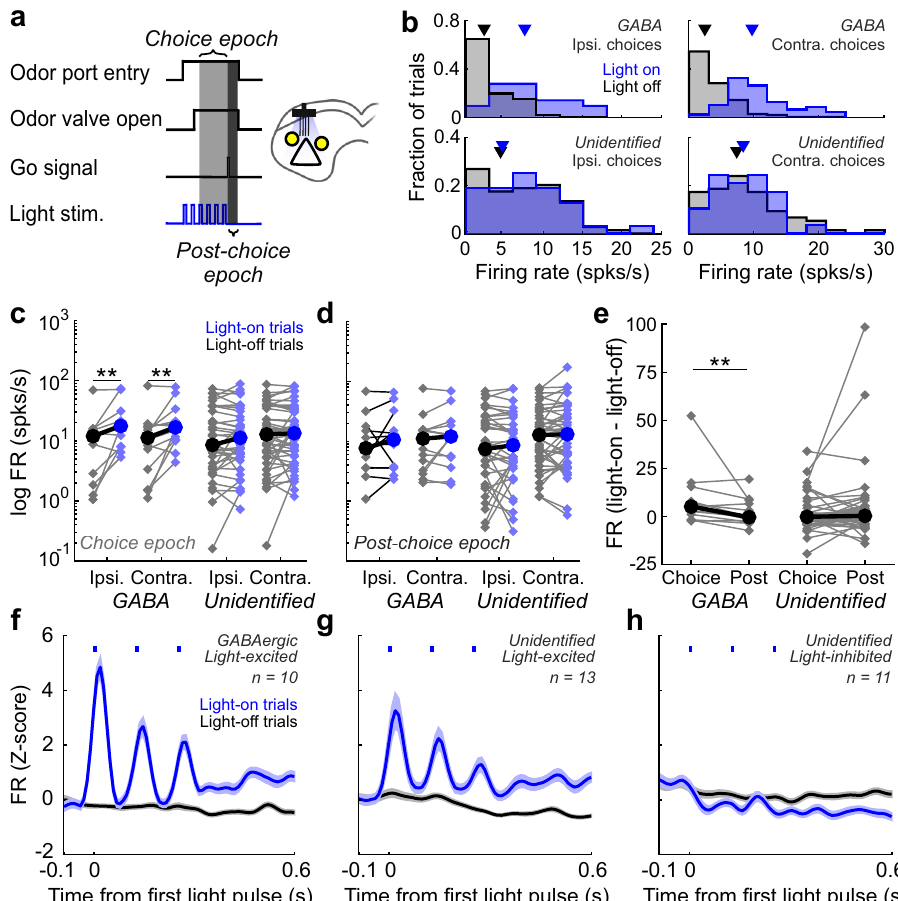
Fig. 3 Effects of photoactivation are restricted to GABAergic SC neurons during the choice epoch. a Schematic of experimental paradigm and epoch de fi nitions, in stimulation/behavior/recording sessions. b Firing rates on light-on (blue) and light-off (black) trials for example GABAergic and unidenti fi ed neurons, separated by choice (ipsi. or contra.). Arrowheads, median fi ring rate. c Effect of photoactivation on local activity in the choice epoch separately for ipsi. and contra. choices. GABAergic: Ipsi. choices, n = 12 neurons, ** p = 0.0034; Contra. choices, n = 14 neurons, ** p = 0.004. Unidenti fi ed: Ipsi. choices, n = 37 neurons, p = 0.79; Contra. choices, n = 48 neurons, p = 0.98, two-tailed Wilcoxon signed-rank tests. Neurons were analyzed if they met fi ring rate criteria (Methods). Each neuron is represented by a connected pair of small symbols. Large symbols show population medians. d As in ( b ), for activity in the post-choice epoch. GABAergic: Ipsi. choices: n = 12 neurons, p = 0.52; Contra. choices: n = 14, p = 0.76. Unidenti fi ed: Ipsi. choices: n = 37 neurons, p = 0.52; Contra. choices: n = 48 neurons, p = 0.36, two-tailed Wilcoxon signed-rank tests. See also Supplementary Fig. 6. e Difference in light response between the choice epoch and post-choice epoch for ipsi. and contra. choices combined for GABAergic neurons (** p = 0.0017, Wilcoxon signed- rank test) and unidenti fi ed neurons ( p = 0.26, Wilcoxon signed-rank test). f Mean z-scored fi ring rate for GABAergic neurons that exhibited a signi fi cant increase in fi ring rate on light-on trials during the choice epoch (Light-excited; n = 10/14 neurons; Supplementary Table 2). Activity on ipsilateral trials is shown; activity on contralateral trials was similar. Blue ticks, light delivery. Shading, ± SEM. g As in ( f ), for unidenti fi ed neurons that increase their fi ring rates (Light-excited; n = 13/51 neurons). h As in ( f ), for unidenti fi ed neurons that decrease their fi ring rates (Light-inhibited; n = 11/51 neurons). by the correlation between light-driven and spontaneous population of neurons increased during light-on trials beyond action potential waveforms ( r 2 > 0.95; Supplementary Fig. 5e; endogenous activity levels (measured during light-off trials) when Methods). mice chose either the ipsilateral target (Fig. 3c; p = 0.0034) or the contralateral target ( p = 0.004, two-tailed Wilcoxon signed-rank tests). Neuron-by-neuron analyses also revealed that 71% of GABAergic neurons exhibited a signi fi cant overall increase in fi ring rate during the choice epoch (Supplementary Table 2; Fig. 3f). Conversely, light had no overall effect on the activity of our mentary Fig. 5e), in a subset of stimulation/behavior sessions unidenti fi ed population of neurons (Fig. 3c; Ipsi. choices: p = (Fig. 3; n = 15 stimulation/behavior/recording sessions; Supple- 0.79; Contra. choices: p = 0.98; two-tailed Wilcoxon signed-rank mentary Table 1). We then compared single-unit fi ring rates on tests), with only 47% of unidenti fi ed neurons exhibiting any light- light-on trials to light-off trials, separately for ipsilateral and induced change in fi ring rate, with approximately as many contralateral choices, for the choice epoch (de fi ned as the time exhibiting an increase (Fig. 3g; n = 13; p < 0.05) as exhibiting a from 100 ms after odor valve open until the go signal; Fig. 3a, b; decrease (Fig. 3h; n = 11; p < 0.05, Mann – Whitney U tests) Methods). We found that the activity of our GABAergic (Supplementary Table 2). In addition to con fi rming that light had COMMUNICATIONS BIOLOGY| (2021) 4:719